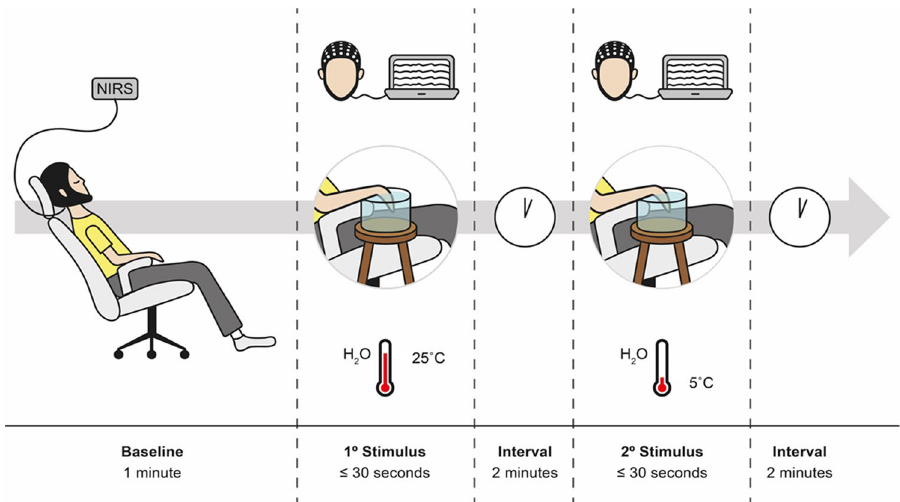
Figure 2. Timeline of the experimental paradigm. Timeline of each assessment pre- and post-thermal stimuli with primary stimulus (at 25 °C) and secondary stimulus (at 5 °C). The cold test was induced by the immersion of the right hand in the water for 30 s or until feeling the first pain sensation with both stimuli and a break of 2 min between each